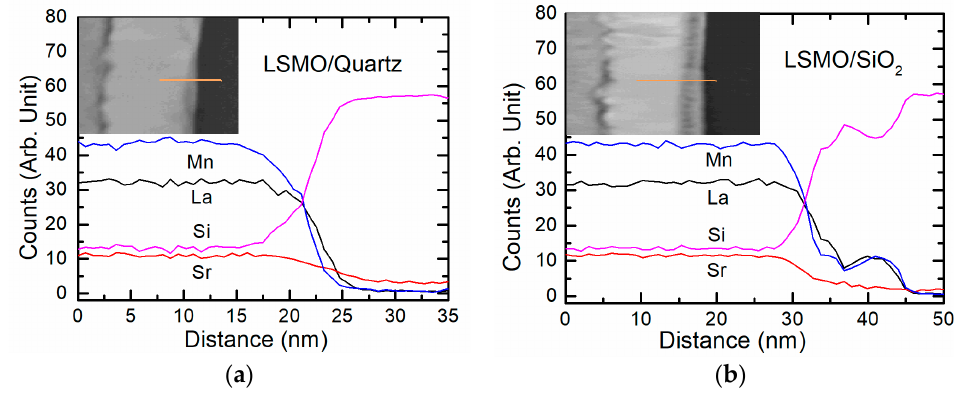
Figure 7. Normalized TEM-EDS line profiles of the elements of 60 nm thick LSMO grown on quartz ( a ) and Si/SiO 2 ( b ) substrates. Insets—cross-sectional STEM Z-contrast image with marked scanning lines.